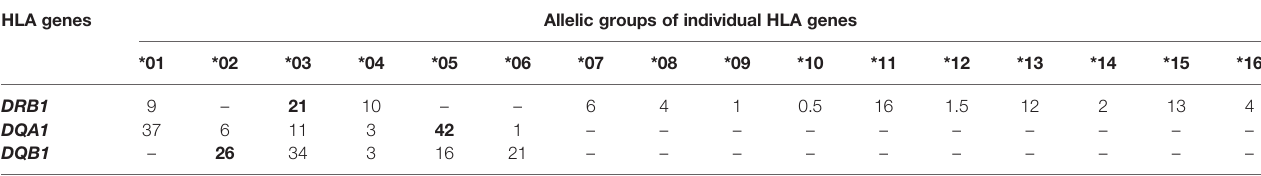
HLA genes Allelic groups of individual HLA